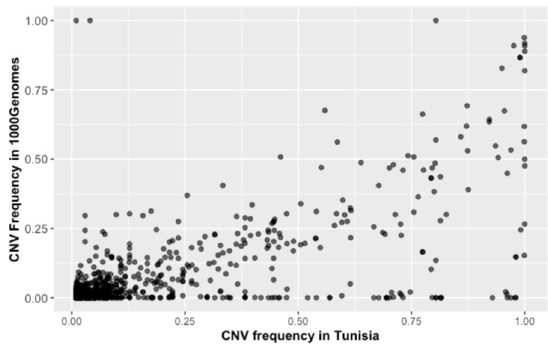
Fig. 2 Scatter plot of frequencies of CNVs in Tunisia identi fi ed in the 1000 Genome project. A positive and high correlation is shown (Pearson correlation r = 0.70, 95% CI = [0.67;0.73], p value < 2.2e –